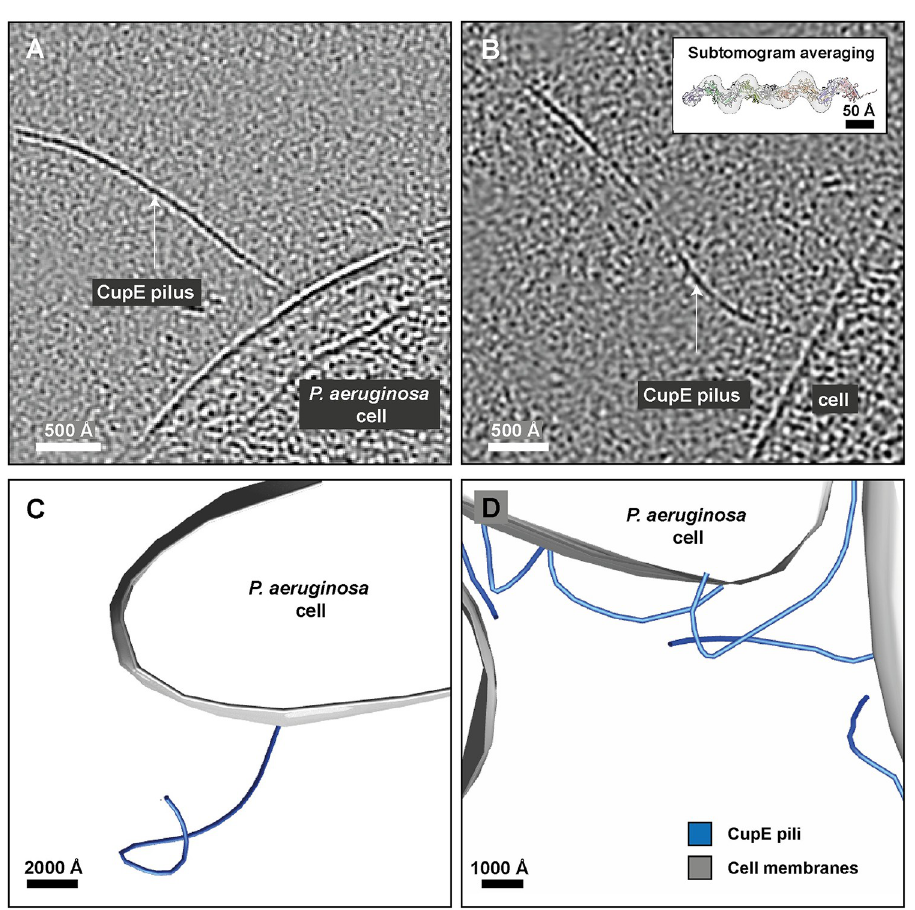
Fig 3. Cryo-ET imaging of CupE pili on P . aeruginosa cells. (A-B) Tomographic slice of cells expressing CupE pili. CupE pili adopt significant curvature on cells. The pilus can be seen going in and out of plane in (B). Inset: Atomic model of CupE fitted in the subtomogram averaging map produced from cellular cryo-ET data. (C-D) Segmentation of cell membranes and CupE pili illustrates how CupE pili adopt variable curvatures. See also S2 Movie.